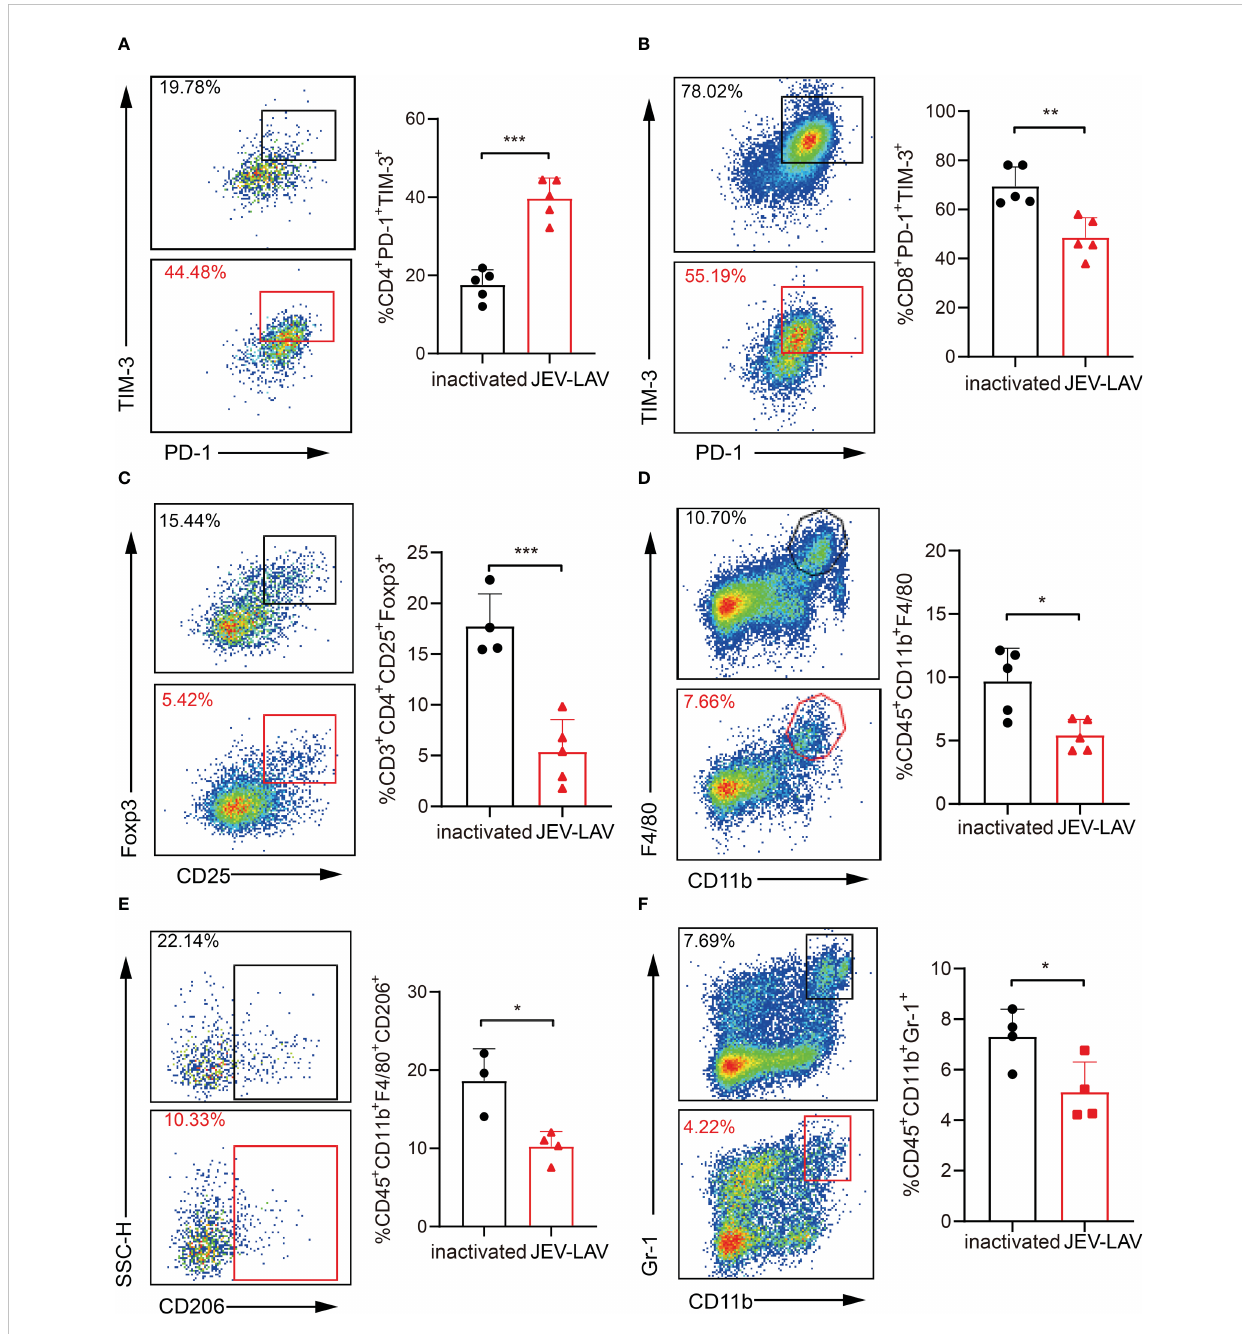
FIGURE 5 JEV-LAV remodels the immunosuppressive GBM microenvironment. The experimental mice were treated as described in Figure 4. The representative fl ow cytometry scatter plots and statistical analysis of the percentage of (A) PD-1 + TIM-3 + cells in CD4 + cells, (B) PD-1 + TIM-3 + cells in CD8 + cells, (C) CD25 + Foxp3 + cells in CD4 + cells, (D) CD11b + F4/80 + cells in CD45 + cells, (E) CD206 + cells in CD11b + F4/80 + cells, and (F) CD11b + Gr- 1 + cells in CD45 + cells. n = 4 or 5 per group. *P < 0.05; **P < 0.01; ***P <